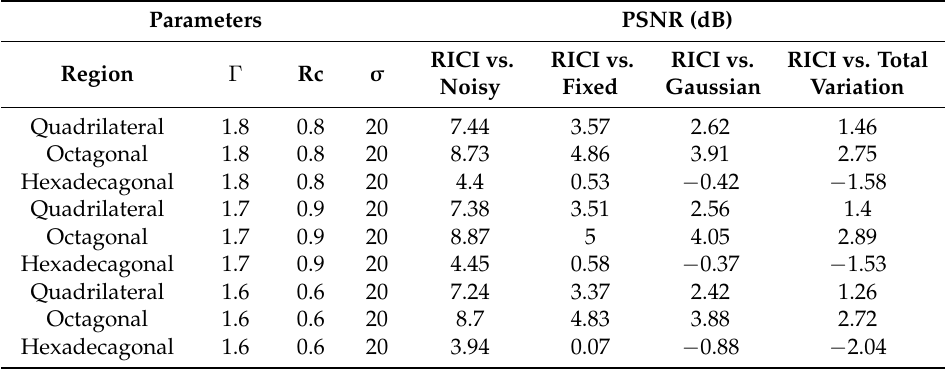
Table 4. PSNR improvements for chest X-ray images denoised using the proposed 2D LPA-RICI method vs. the competitive